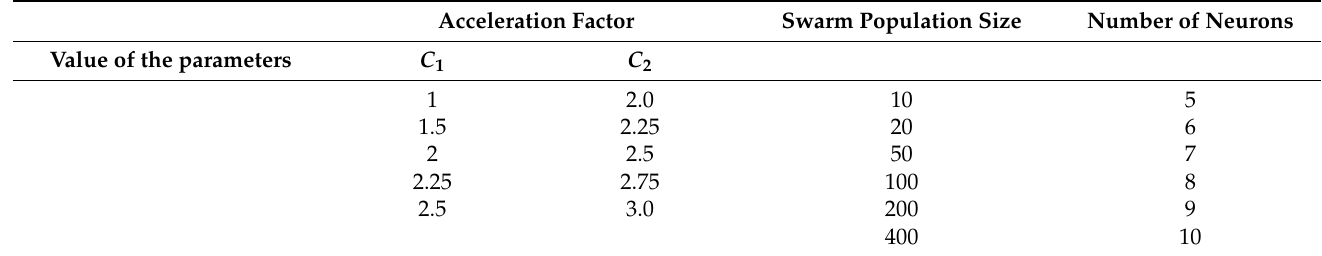
Table 4. Values of parameters of the ANN-PSO model used for the traffic study. Acceleration Factor Swarm Population Size Number of Neurons Value of the